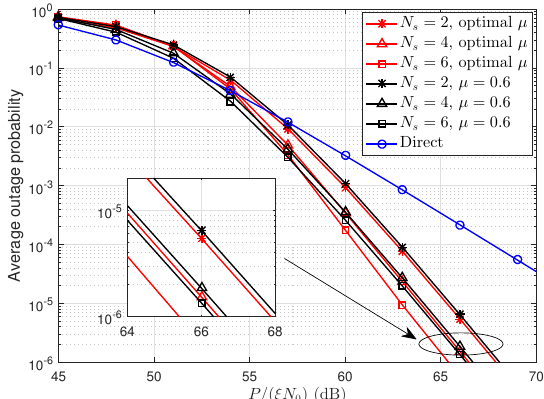
Figure 9. The average outage probability versus P / ( ξ N 0 ) with optimal power allocation and optimal relay location.